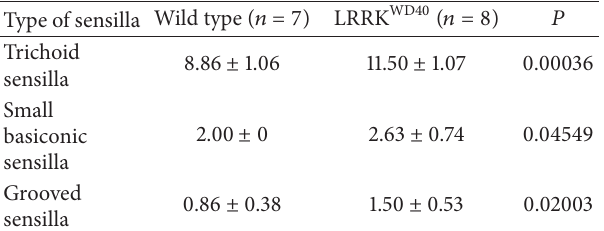
Table 1: Average number ( ± SD) of the three types of sensilla present in a sample area (1,000 𝜇 m 2 ) in the central part of the flagellum of D. melanogaster WT and LRRK WD 40 mutants (Student’s 𝑡 -test, 95% confidence